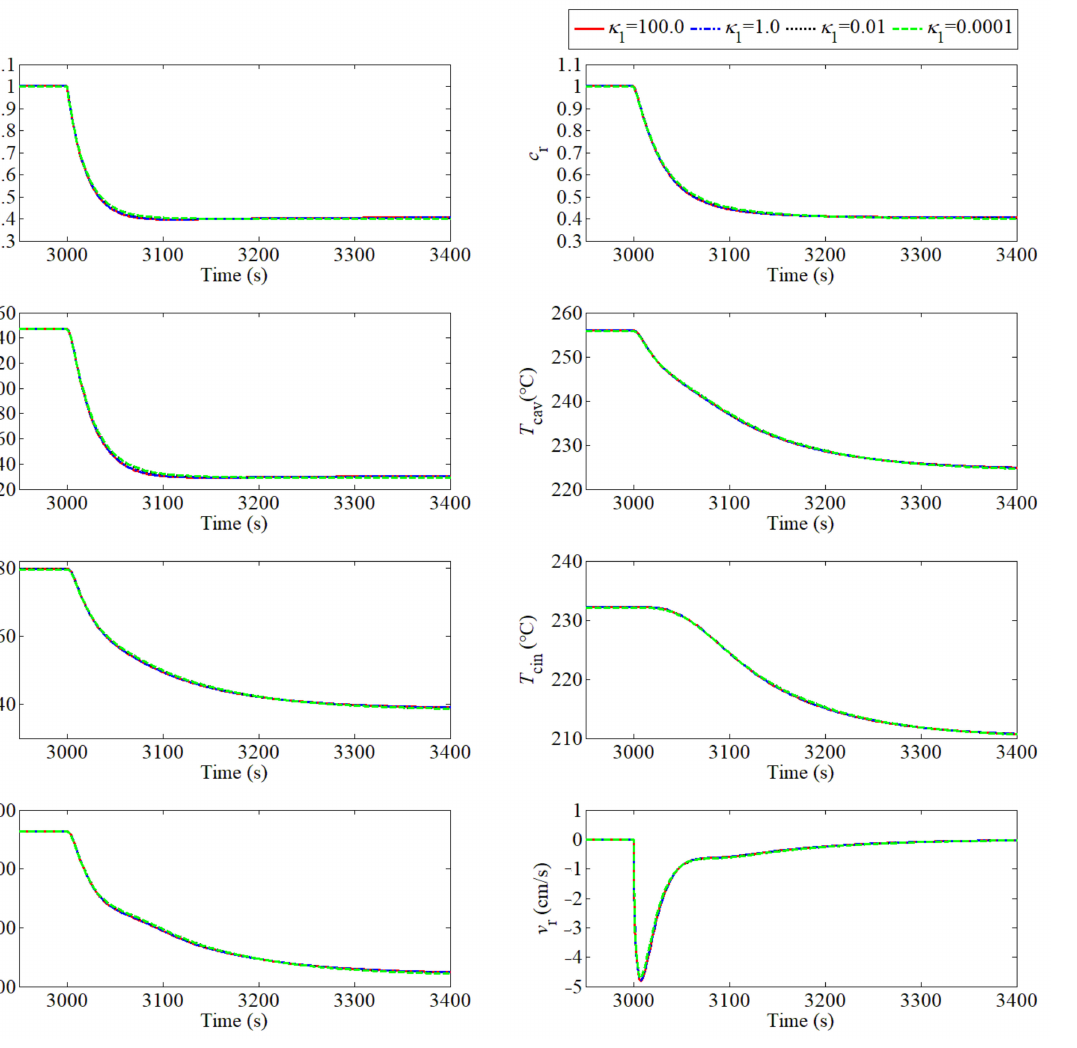
Figure 2. Responses in power stepping with different κ 1 and κ 2 =